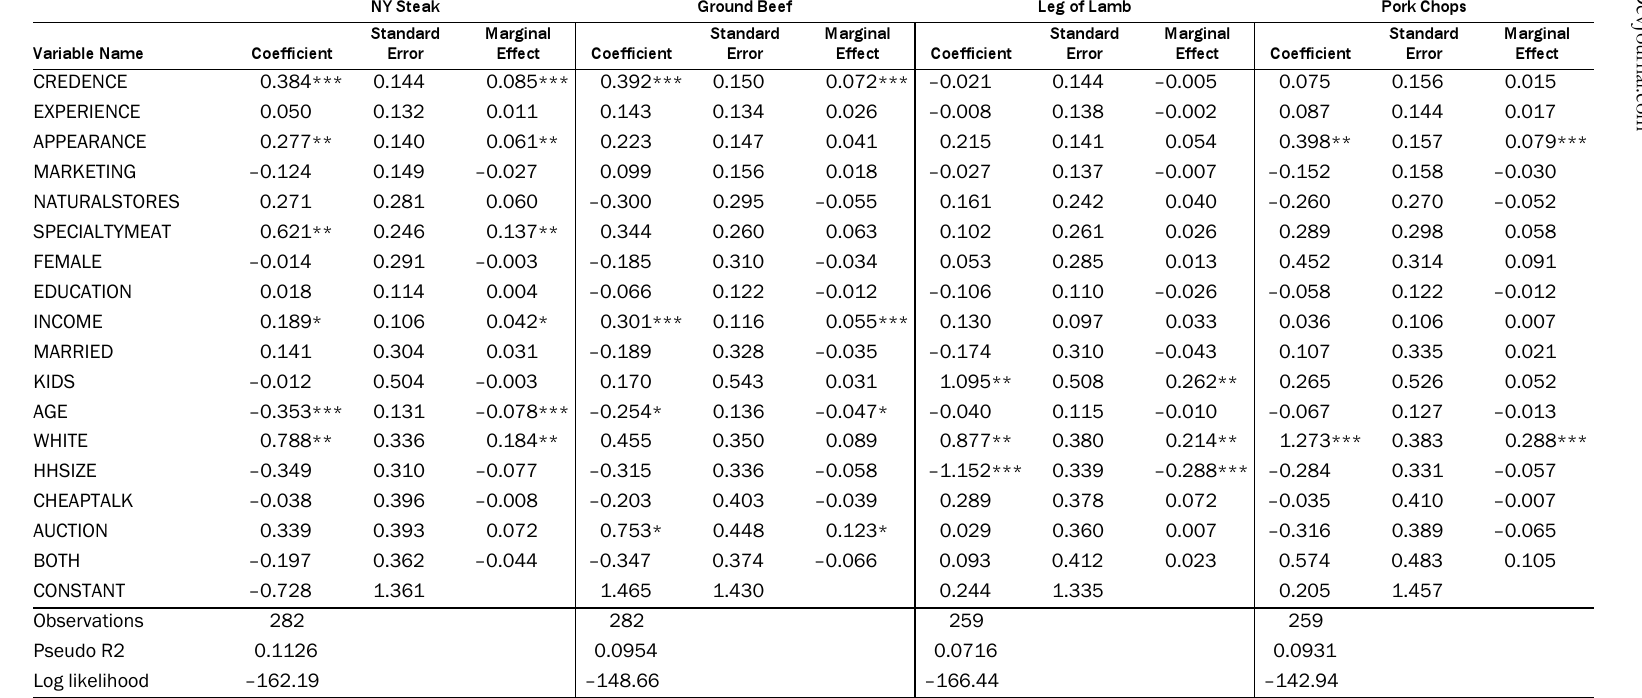
Table A2. Consumer WTP Premium Model Results